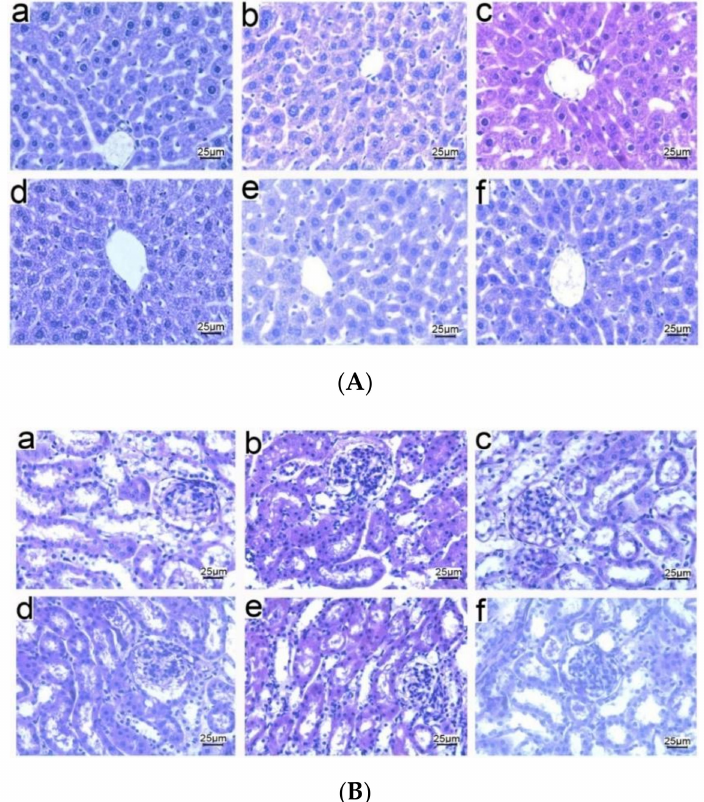
Figure 6. Histopathology of livers and kidneys of immunized mice. Liver ( A ) and kidney ( B ) sections are shown with hematoxylin and eosin (H&E) staining at × 400 magnification. Results of oral administration of NC (a), NP-Empty (b), 4 µ g/g OmpA (c), 4 µ g/g NP-OmpA (d), 8 µ g/g NP-OmpA (e), and intraperitoneal injection of 4 µ g/g NP-OmpA (f) are shown. Liver sections ( A ) show that every group had obvious hepatic sinusoids and cells with regular cell morphology, uniform cytoplasm, and clear nuclei. Kidney sections ( B ) show that every group had normal glomerular interstitium. The results showed that NP-OmpA had no toxic effect on mice livers and